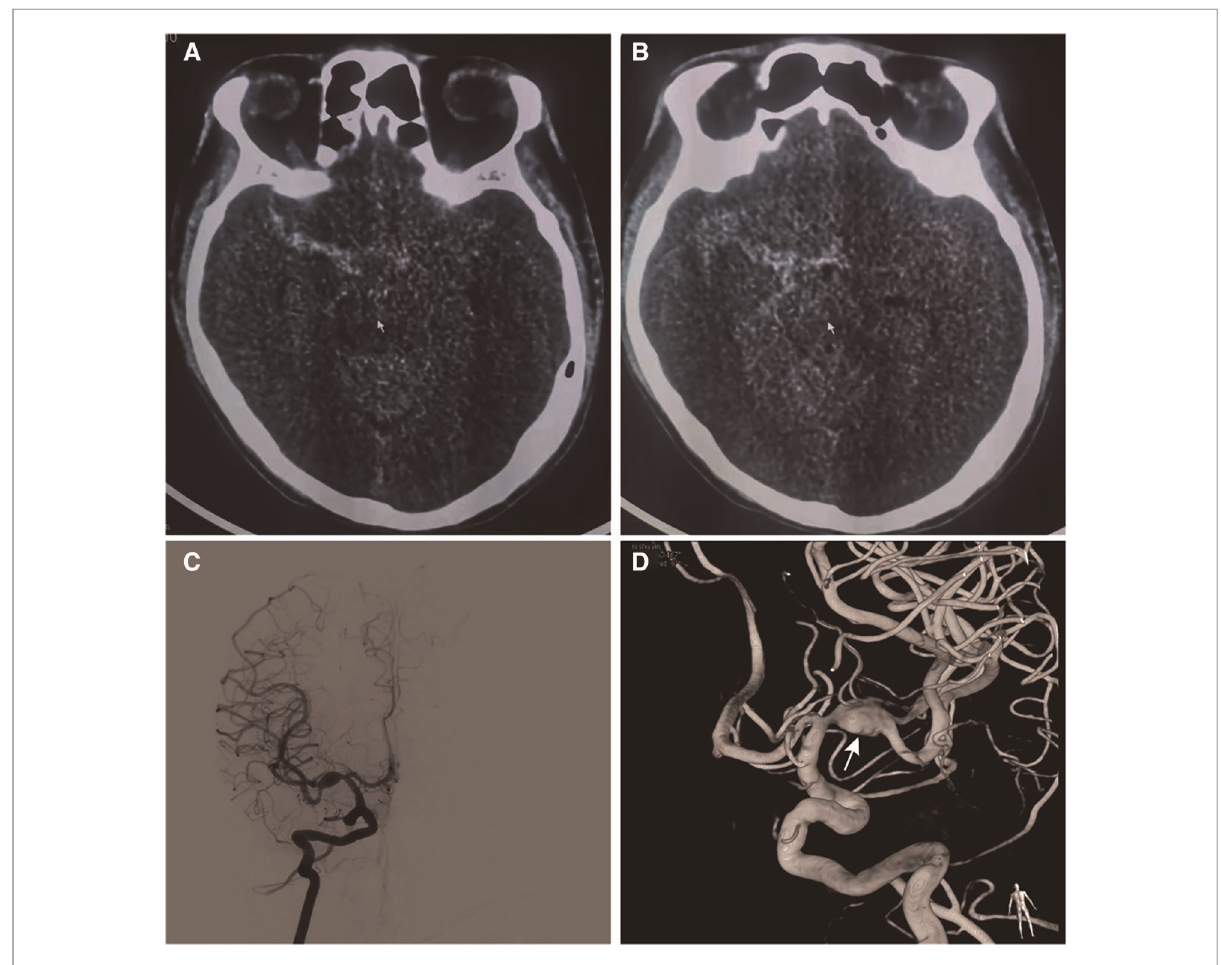
FIGURE 1 ( A ) and ( B ) computed tomography of the head demonstrating subarachnoid hemorrhage. ( C ) Anterior-posterior the right internal carotid artery and ( D ) 3D rotational angiogram demonstrating a fusiform aneurysm of the M1 segment of the right MCA measuring 10.11×6.47 mm. Multiple ascuses (arrow) were visible in the inferior wall of